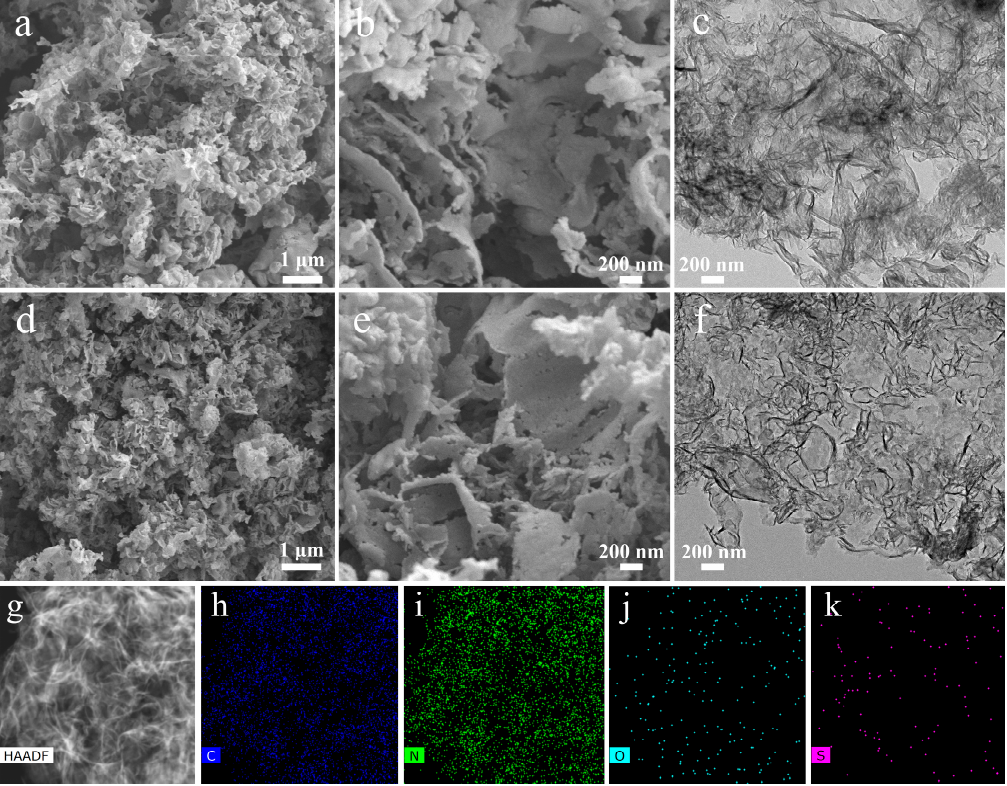
Figure 6. ( a , b ) SEM images and ( c ) TEM image of CN; ( d , e ) SEM images and ( f ) TEM images of TA-CN-2; ( g ) HAADF image and elemental mapping images of ( h ) C, ( i ) N, ( j ) O and ( k ) S of TA-CN-2.